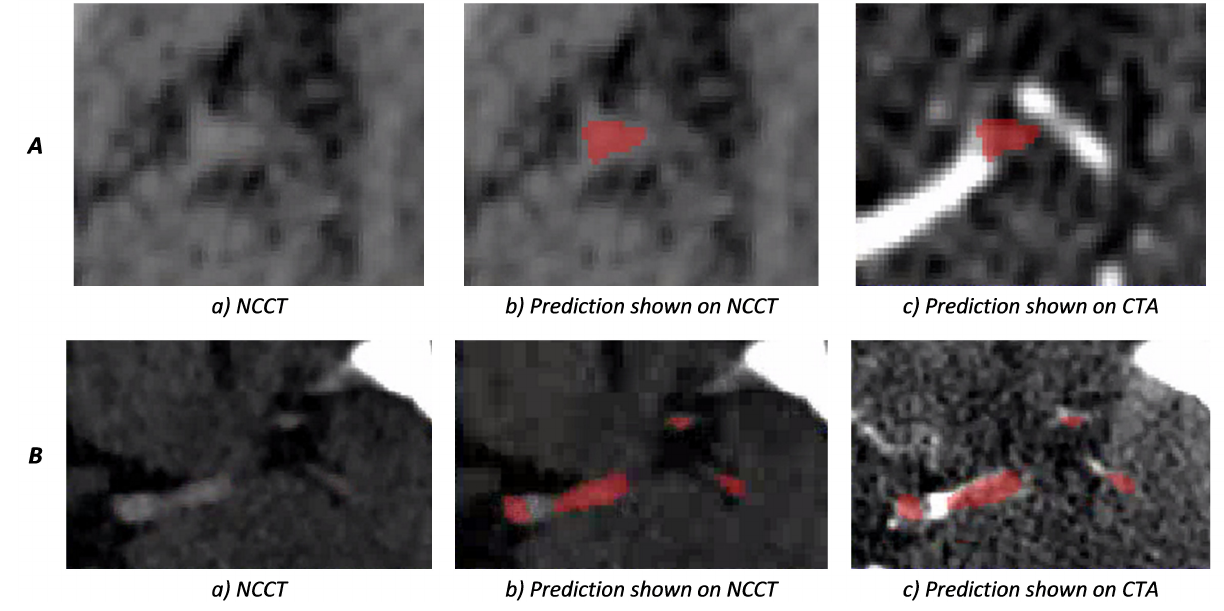
Figure 7. Weighted-sum thrombus segmentation results for two patients. The segmentation predic- tion is depicted in red; ( A ) shows a difficult case in which the network is able to successfully segment a small thrombus where the hyperdense artery sign is not easily distinguishable from the background; ( B ) depicts a case where CTA shows that the thrombus is only partially present in the artery. Part of the non-occluded artery also shows as a hyperdense region on NCCT. Therefore, information from both NCCT and CTA is required to accurately annotate the thrombus. This figure shows that the network is able to discard the area with the visible contrast on CTA from the segmentation.